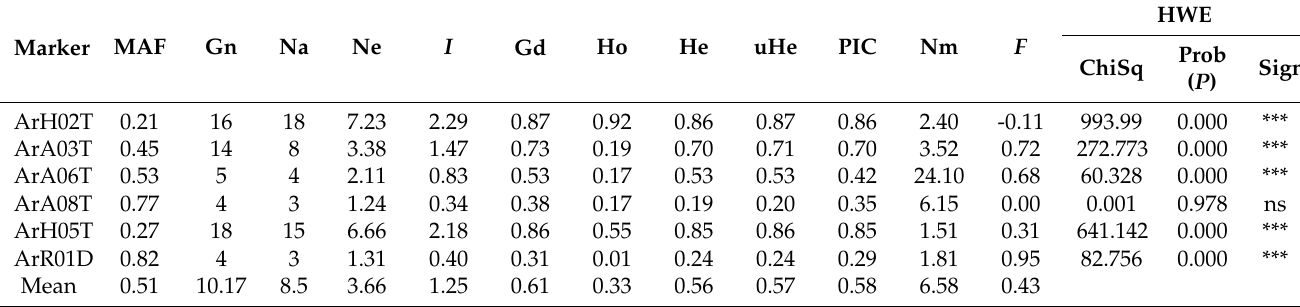
Table 2. Molecular characteristics of the six SSR microsatellite loci based on three D. rabiei populations.